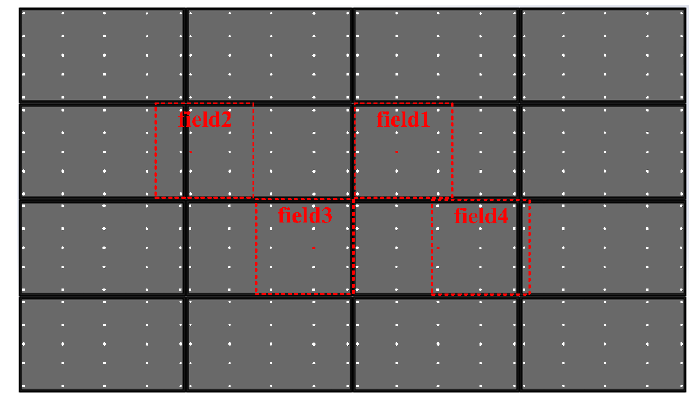
Figure 6. Targets distribution.